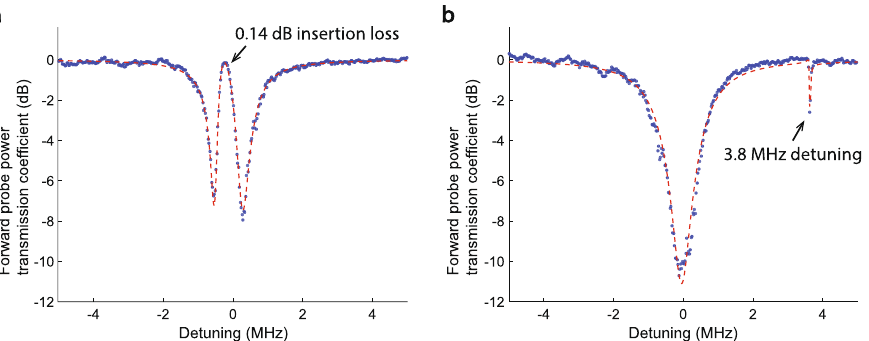
Figure 4. Demonstration of ultra-low forward insertion loss with stronger coupling G . ( a ) Here, we use a triplet of optical and acoustic modes with an optical mode separation or acoustic frequency of 164.8 MHz. Pump- enhanced Brillouin coupling rate G is much higher due to better acousto-optic modal overlap and 235 μ W power absorbed into the control mode. This results in κ ≈ G /3 causing the forward insertion loss within the transparency to decrease to only 0.14 dB. The isolation bandwidth also increases to approximately 400 kHz. ( b ) The transparency-free ( ω 2 , k 2 ) optical mode is observable by detuning the control laser from the ( ω 1 , k 1 ) optical mode, which also detunes the scattered